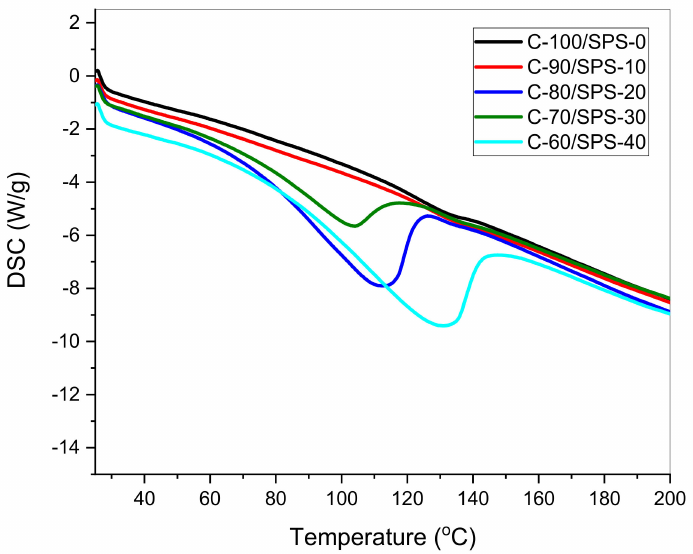
Figure 10. DSC curves for char briquettes with 0, 10, 20, 30, and 40% SPS loading within the temperature range of 25–600 ◦